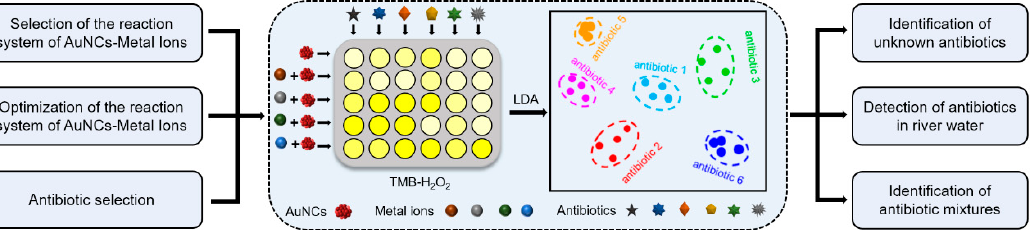
Scheme 1. The schematic diagram of recognition and detection of antibiotics by metal ions and AuNCs based on TMB-H 2 O 2